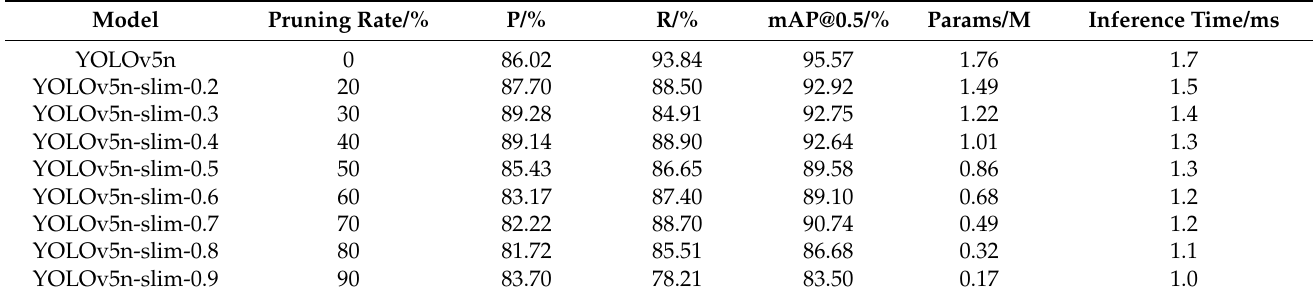
Table 4. Results of model pruning.